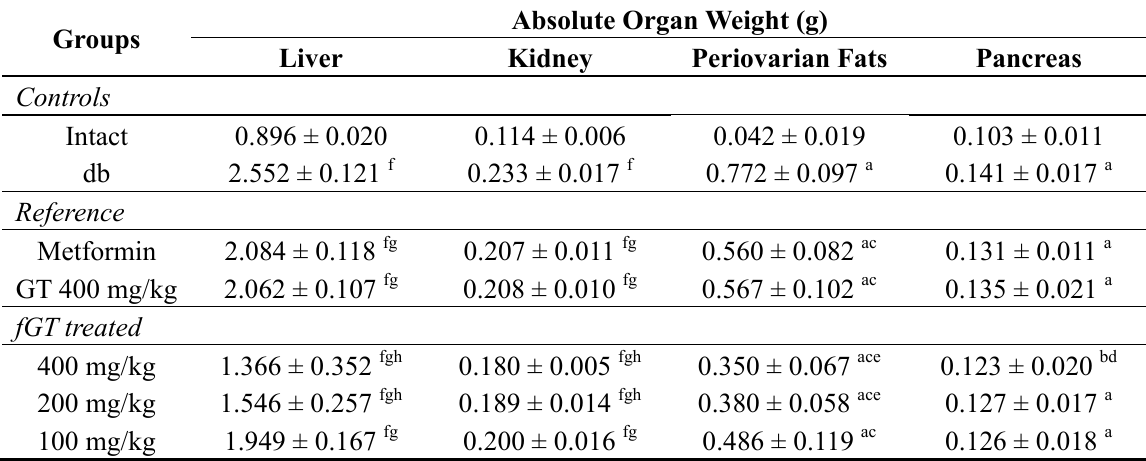
Table 3. Changes on absolute organ weight in intact normoglycemic and db/db mice.